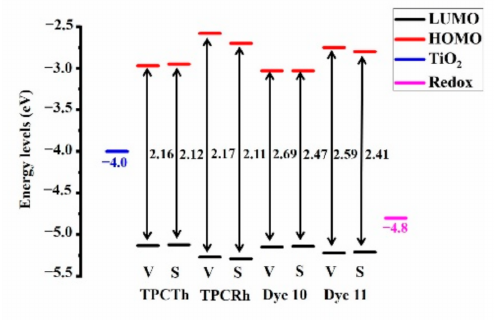
Figure 3. Energy-level diagram of four original